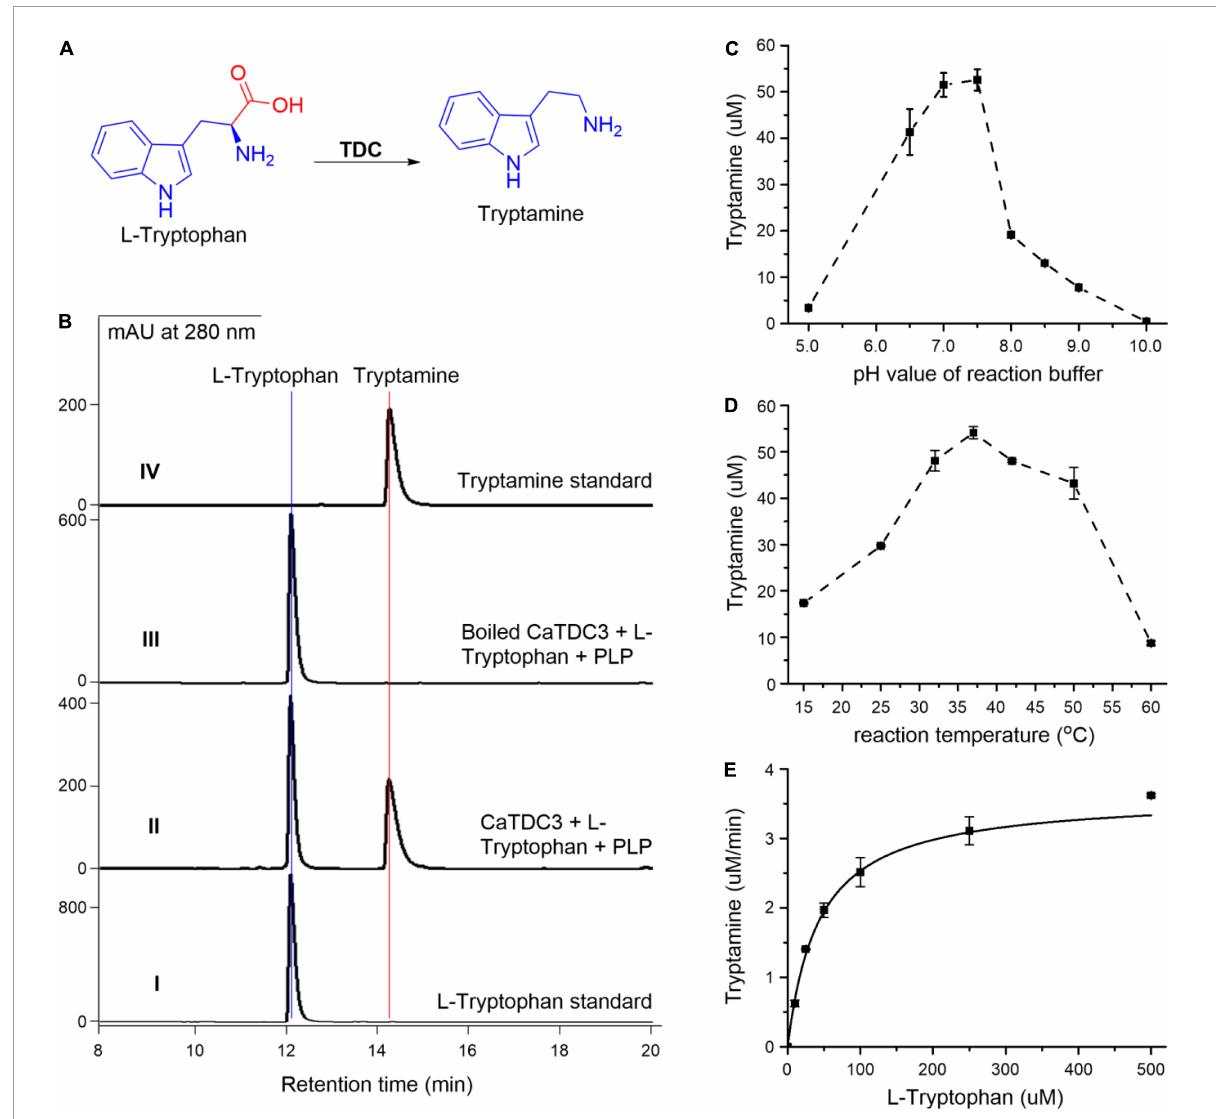
FIGURE5 Functional and biochemical characterization of CaTDC3. CaTDC3-catalyzed decarboxylation reaction of L-tryptophan (A) . (B) HPLC-DAD traces of the decarboxylation reaction mixture catalyzed by CaTDC3 (panel II) and boiled CaTDC3 (panel III). Panels I and IV are authentic L-tryptophan and standard tryptamine, respectively. The effects of pH value of reaction buffers (C) and reaction temperature (D) on the catalytic activity of CaTDC3. (E) The steady kinetics of CaTDC3 toward